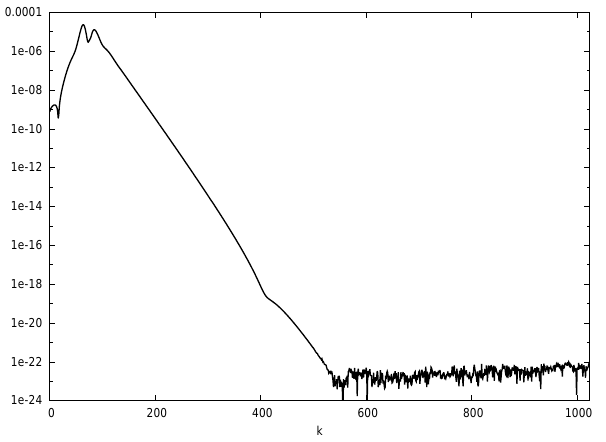
Figure 9. Fourier spectrum | b k | after 100 collisions.